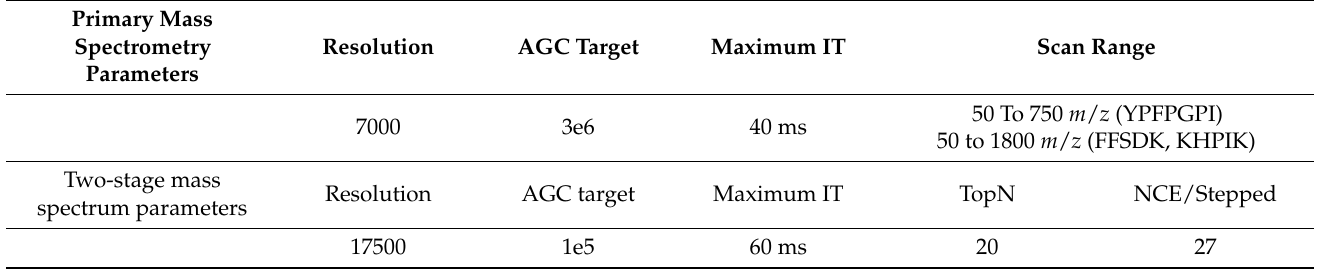
Table 2. Mass Spectrometer